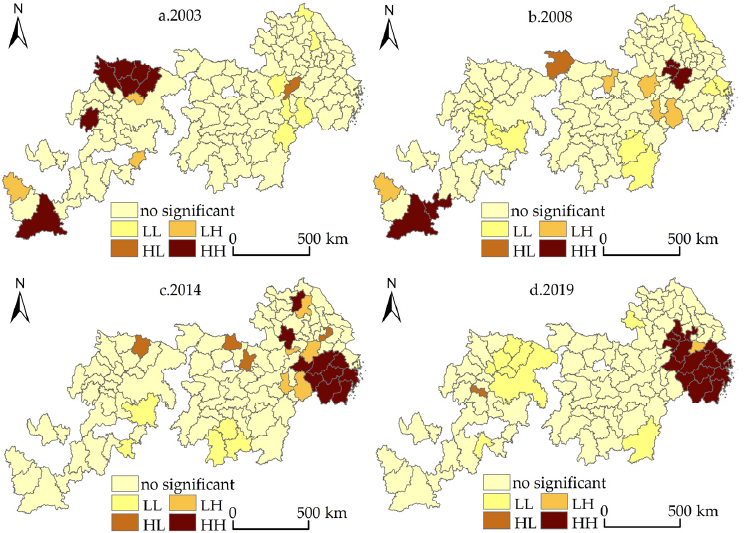
Figure 6. LISA gathering plot of ULUE in the Yangtze River Economic Zone. ( a ) LISA in 2003; ( b ) LISA in 2008; ( c ) LISA in 2014; ( d ) LISA in 2019. According to the Local Moran scatter plot, during the study period, most cities in the Yangtze River Economic Zone were in I and III quadrants (ULUE showed spatial positive